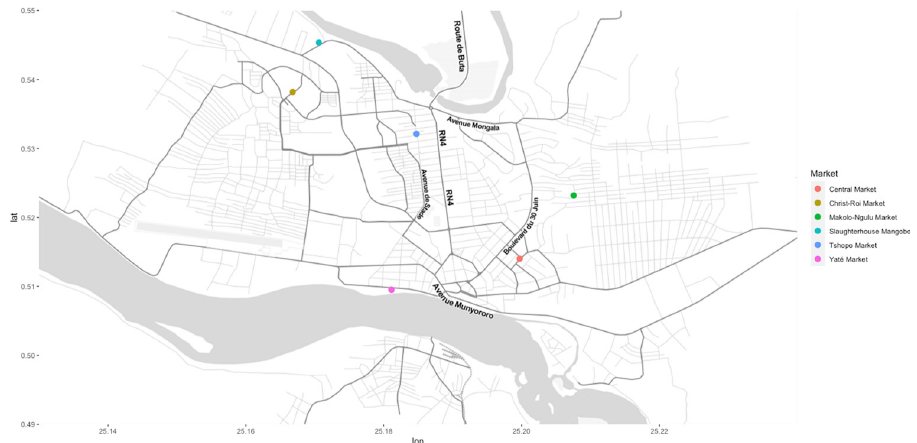
Fig 1. Overview of sampling sites in Kisangani city. Kisangani map was made using OpenStreetMap data, Stamen open source maps (https://stamen.com/open-source/) and the R-package ggmap [34].